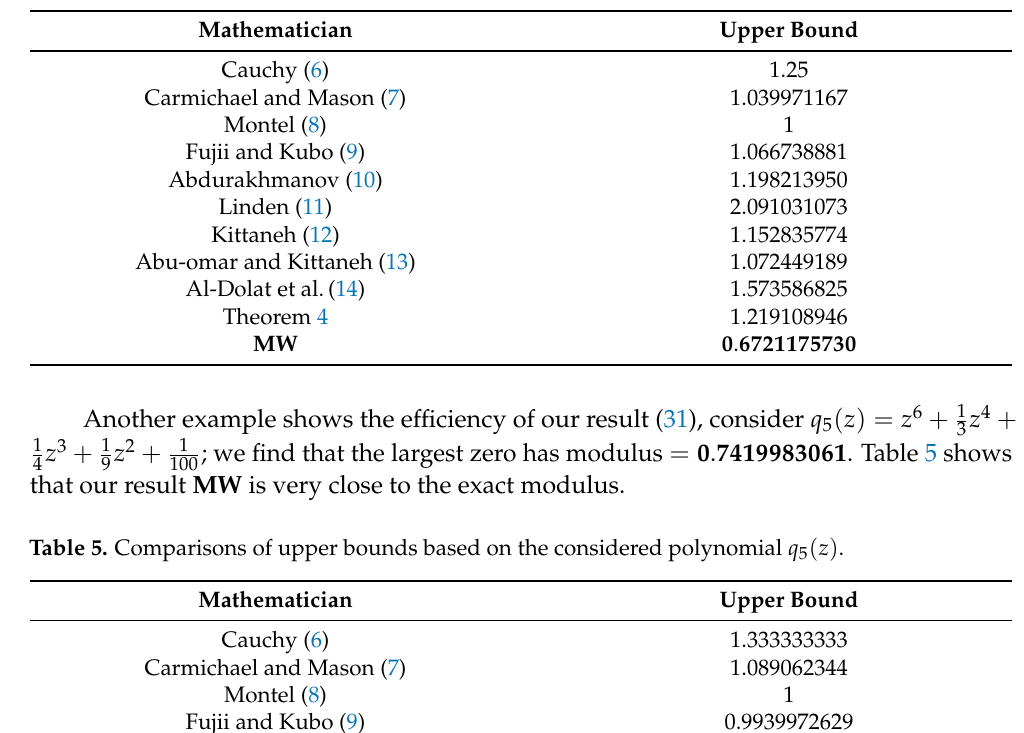
Table 4. Comparisons of upper bounds based on the considered polynomial q 4 ( z ) .